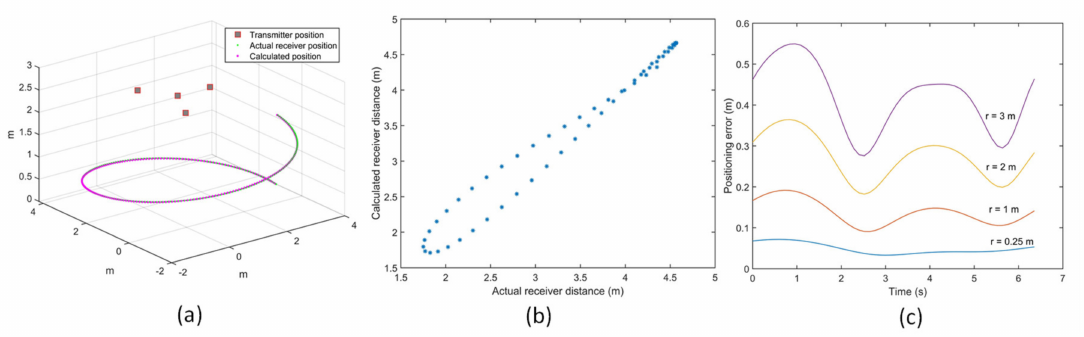
Figure 10. ( a ) Receiver motion in a spiral trajectory at 3 m / s (r = 3 m). ( b ) Actual vs calculated receiver distance at 3 m / s. ( c ) Positioning error propagation due to receiver moving at di ff erent